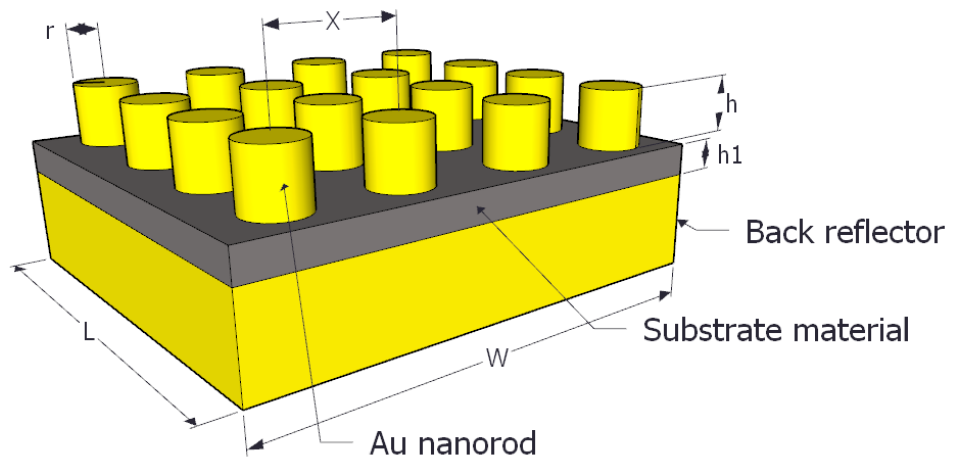
Figure 1. Schematic diagram of the adopted typical MMA